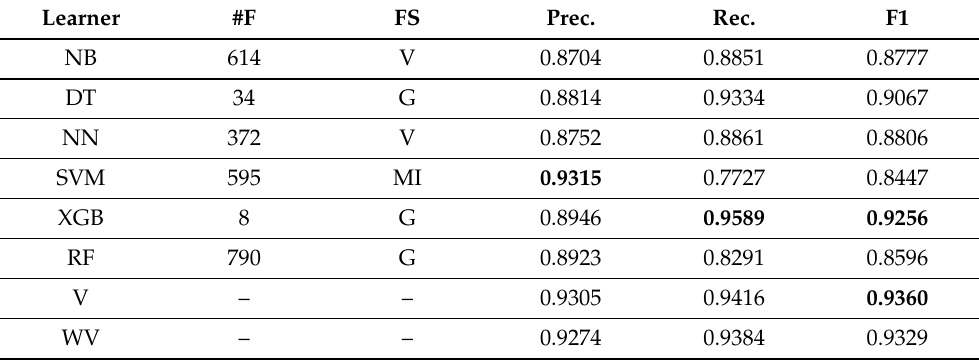
Table 4. Cross validation results with tweet and user features. The best results are marked in